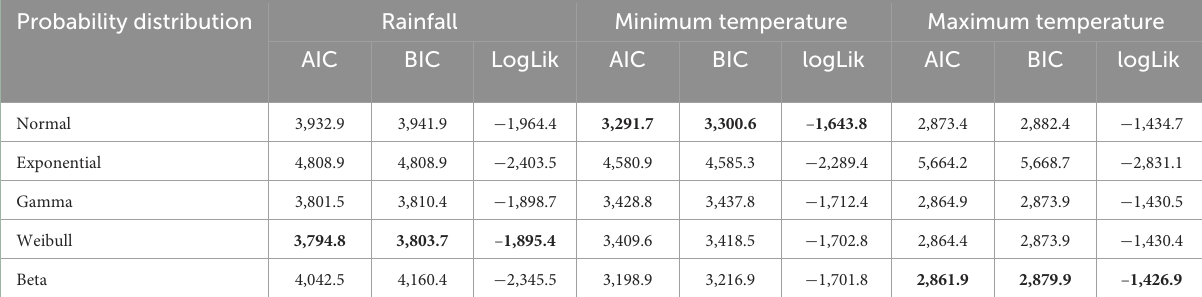
TABLE 6 The goodness of fit values of AIC, BIC and log likelihood of marginal distributions of the mean rainfall, maximum and minimum temperature.